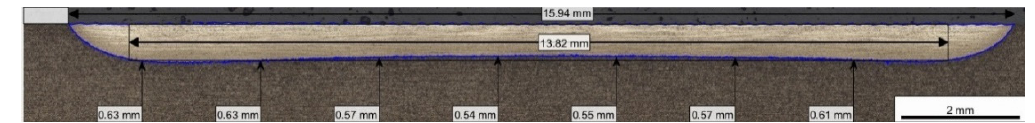
Figure 12. Simulated temperature field at a depth of 0.1 mm in 42CrMo4 (AISI 4140) for the optimized profile at the feed of 800 ( a ) and 1000 mm/min ( b ).